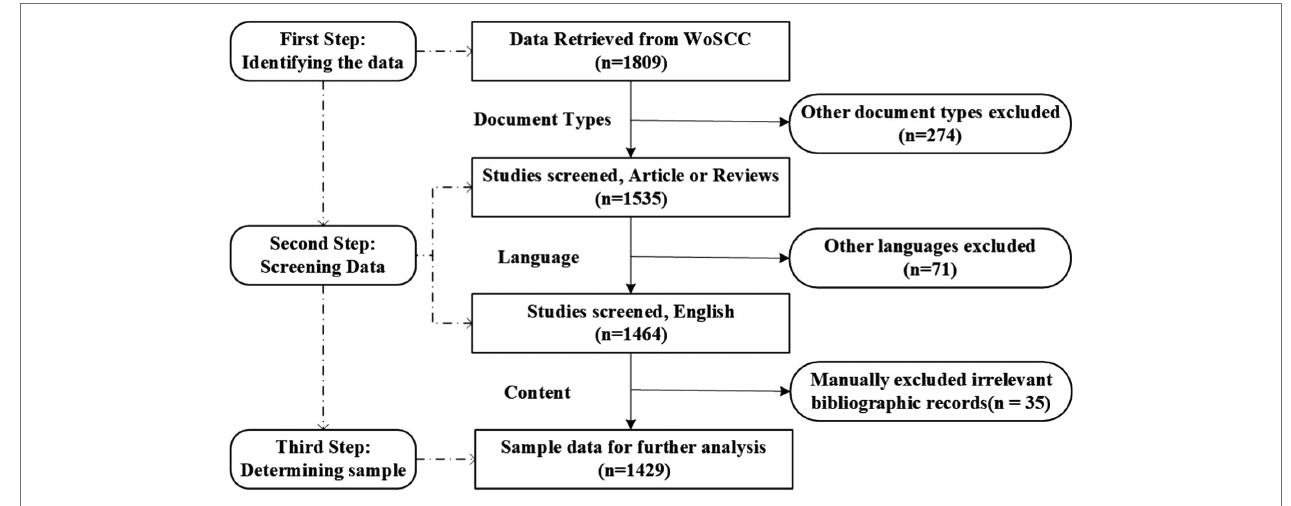
FIGURE 1 | The flowchart of retrieving expressive writing publication bibliographies. WoSCC, Web of Science Core